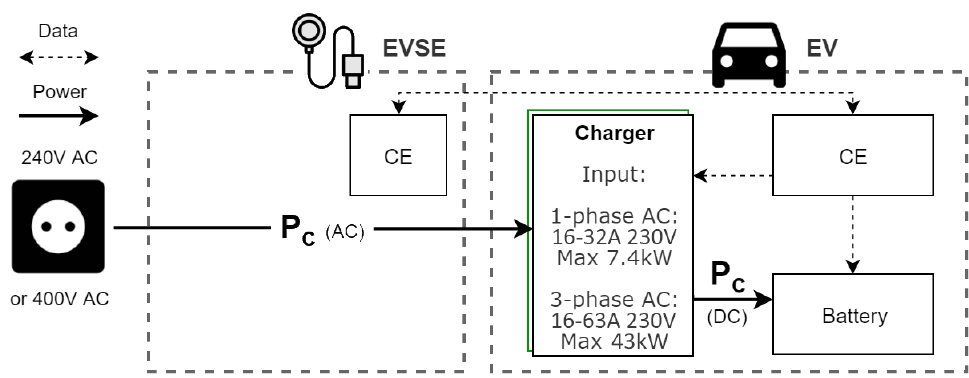
Figure 2. EV charging with a Mode 3 charging point. Energy is converted to DC by the charger inside the EV, restricting charge speeds. Note that the Control Electronics (CE) of the EVSE and EV communicate for security checks only.